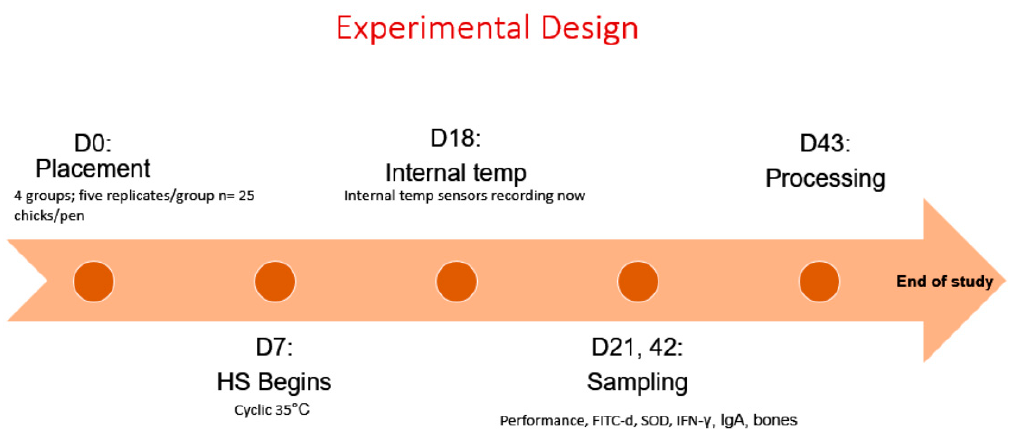
Figure 1. Experimental